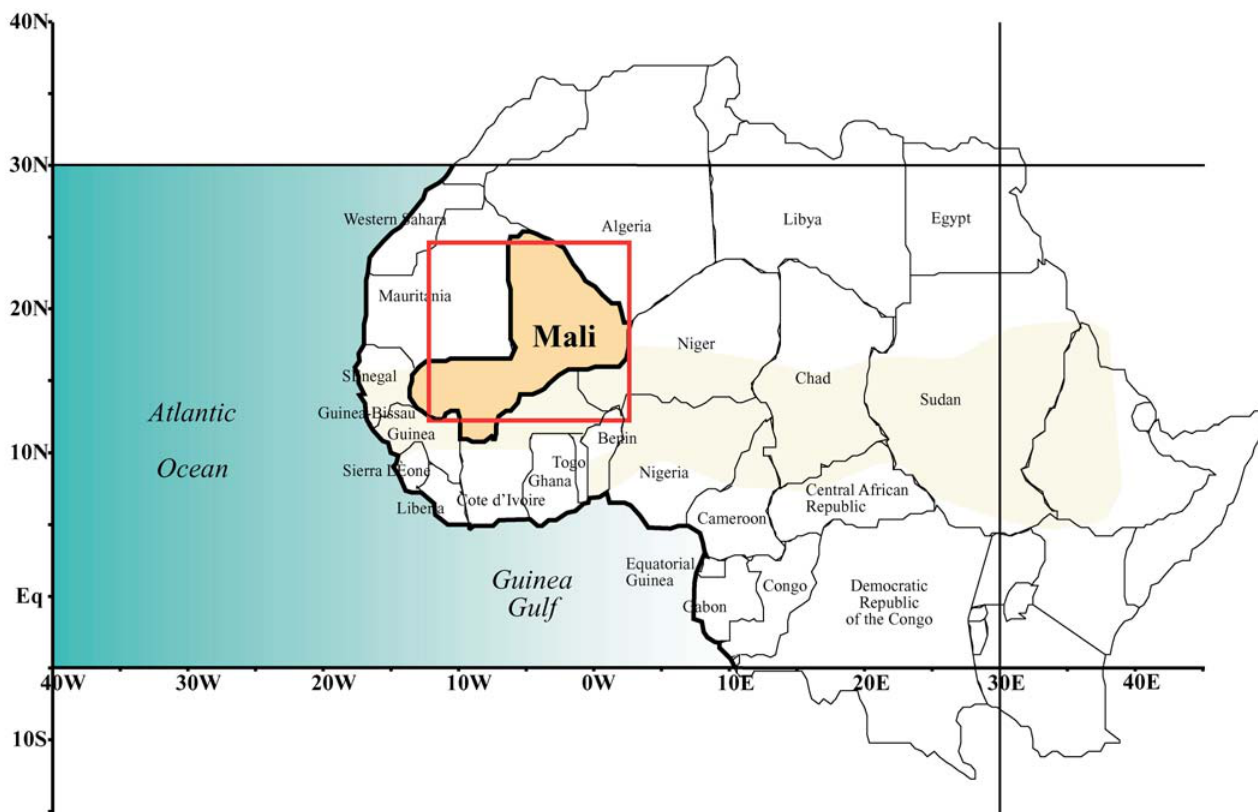
Figure 1. The ‘‘ Meningitis Belt ’’ in West Africa Modified from the WHO [9]. DOI: